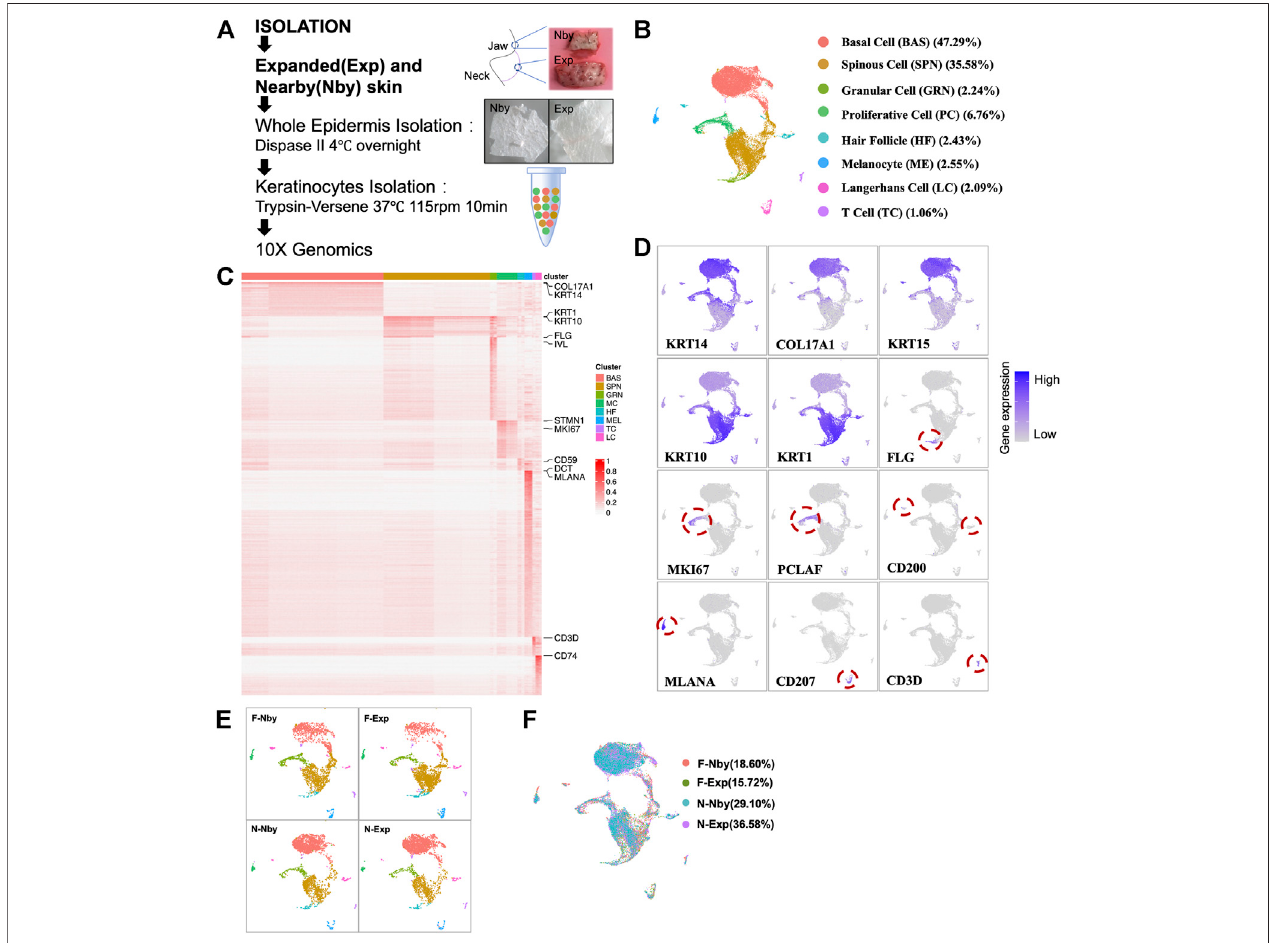
FIGURE 1 | ScRNA-seq reveals similar cell type composition in epidermal keratinocytes after long-term stretch. (A) Overview of the experimental work fl ow. Paradigmofsingle-cellisolationandsequencingstrategy(right).White fi eldimagesoftheexpandedandnearbyskinofhumans(left). (B) Uniformmanifoldapproximation andprojection(UMAP)clusterofepidermalcells( n =22223)fromexpanditsnbyskin.Majorcelltypesareclassi fi edusingmarkergenesandcolorscorrespondingtocell identity. (C) Heatmap of differentially expressed genes. Selected genes for each cluster are shown on the right. (D) UMAP plots show the representative marker genes of each cell type in human skin. The color key from gray to purple indicates low to high gene expression levels. (E) UMAP plot presents 3,000 cells and the same celltypesineachofthefoursamples.Cellsarecoloredbysample,andthepercentageofeachsampleisannotatedtotheright. (F) UMAPplotshowingsimilarpatternsof cell clustering for each